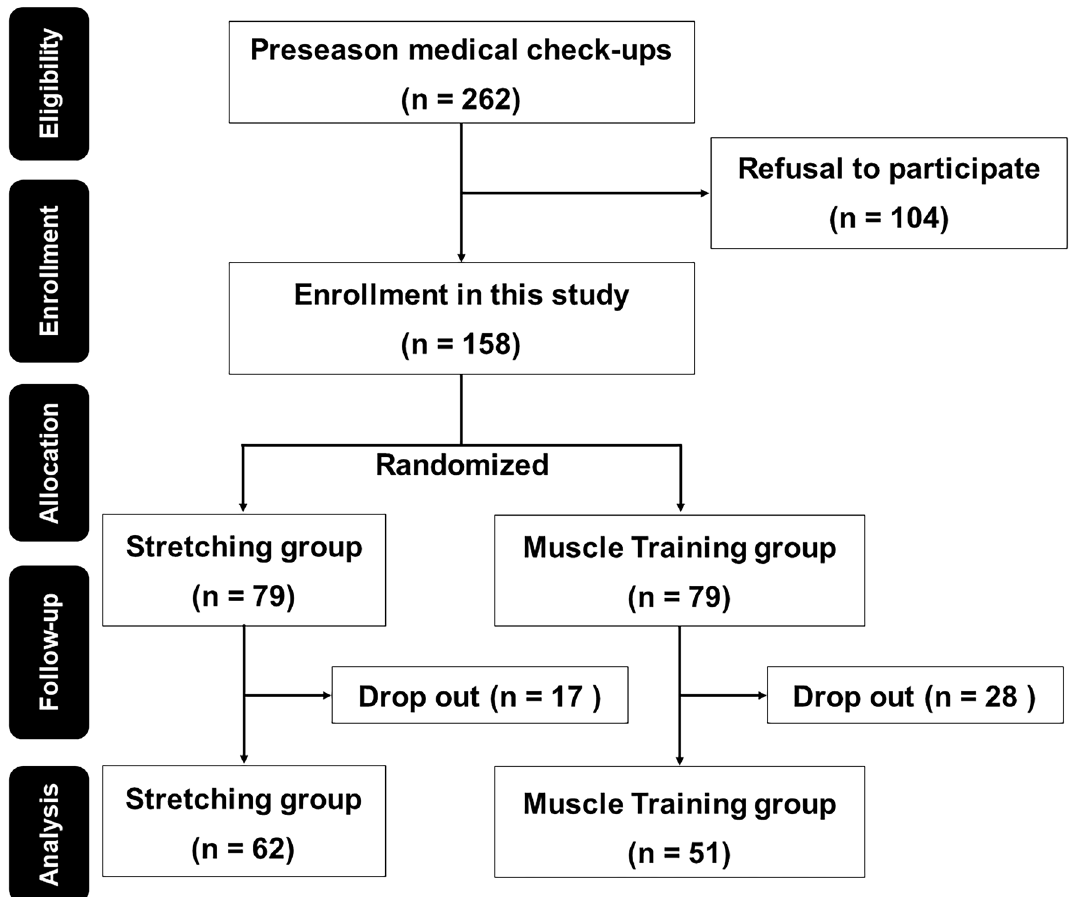
Figure 1. Consolidated Standards of Reporting Trials flow diagram. The Consolidated Standards of Reporting Trials (CONSORT) diagram shows the recruitment, allocation, follow-up, and analysis of the